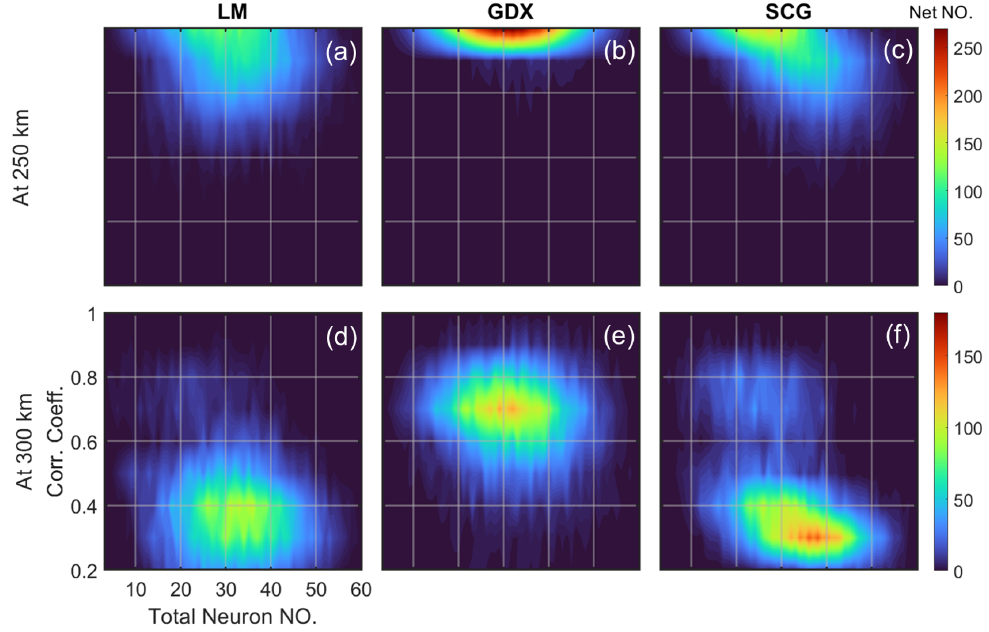
Figure 7. The relation between the number of nets with specific total neuron number in a net and the correlation coefficients of RO-VERs at 250 km ( a – c ) and 300 km ( d – f ) trained with LM, GDX, and SCG algorithms in alphabetical